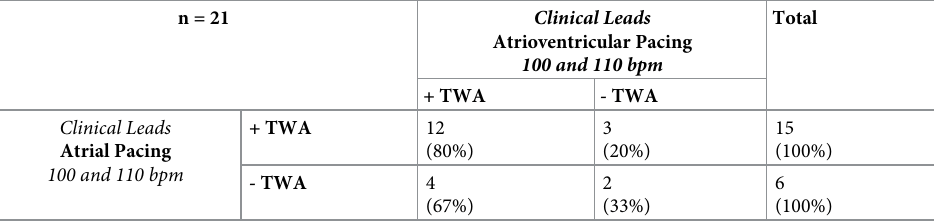
Table 6. Effect of pacing mode on clinically +TWA beginning with atrial pacing.